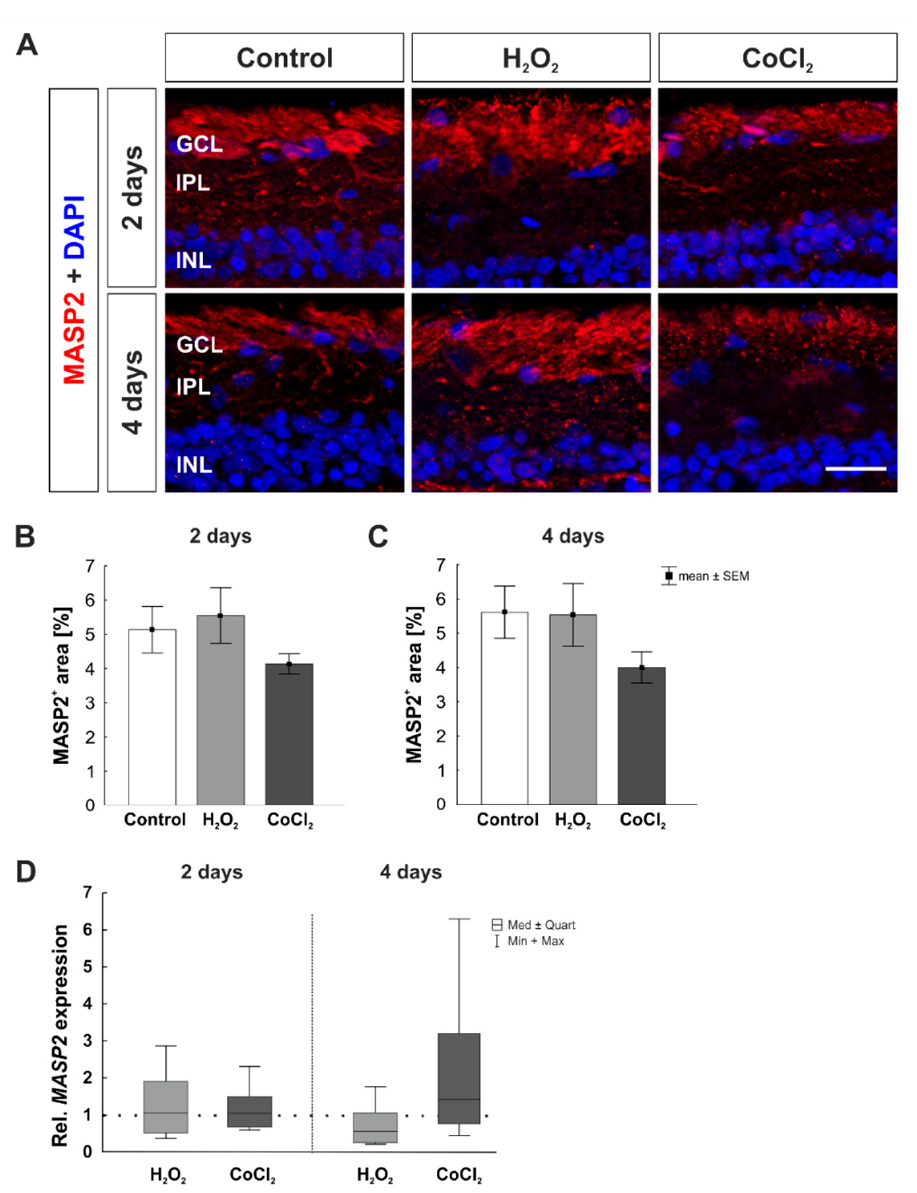
Figure 8. No activation of the complement system via the lectin pathway. ( A ) For investigation of the lectin pathway, a MASP2 antibody were used (red). Cell nuclei were stained with DAPI (blue). ( B ) MASP2 + staining area was not altered in any of the groups at two days. ( C ) Additionally, at four days, no changes were found in MASP2 + signal area. ( D ) In accordance, mRNA expression levels of MASP2 remained unchanged after H 2 O 2 or CoCl 2 application. GCL = ganglion cell layer; IPL = inner plexiform layer; INL = inner nuclear layer. B, C: n = 8; D: n = 4–5. Scale bar: 20 µ m. Values are shown as mean ± SEM for immunofluorescence median ± quartile +min/max for RT-qPCR. The dotted line in D represents the relative expression of the control